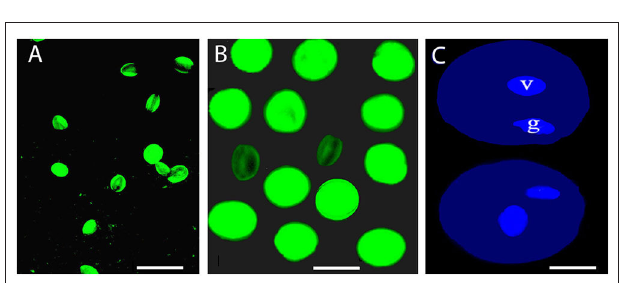
FIGURE 2 | Pollen viability after storage treatment. (A) Pollen viability of cv. Kožara (bar = 50 µ m) and cv. Budimka (B) after 6 months of storage at − 80 ◦ C (bar = 20 µ m). (C) Vegetative (v) and generative (g) nucleus of fresh cv. Budimka pollen after staining with DAPI (bar = 10 µ m).